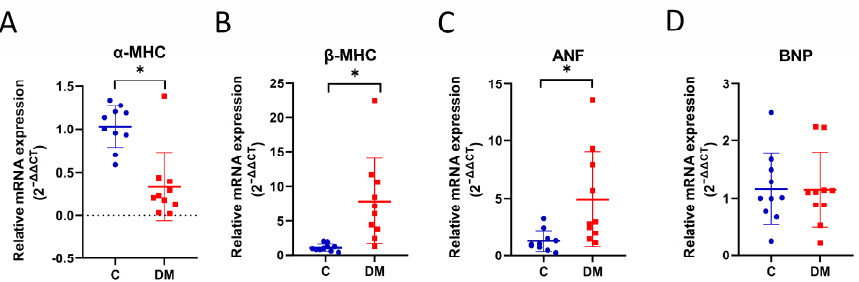
Figure 4. Changes in MHC and ANF mRNA in diabetic HFpEF hearts. Expression of mRNA was examined using RT-qPCR. ( A ) α-MHC, ( B ) β-MHC, ( C ) ANF and ( D ) BNP mRNA levels in the heart. Data are expressed as mean ± SEM ( n = 10). p -values were determined by Student’s t -test. * p < 0.05 DM vs. C.